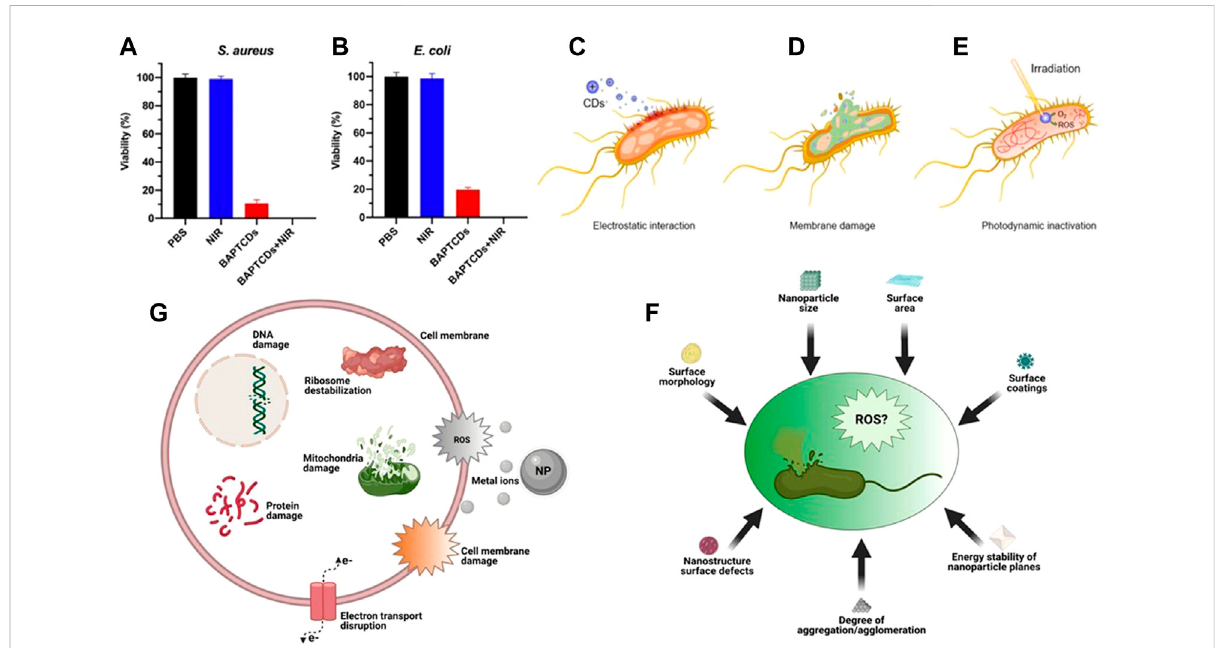
FIGURE 6 Bacterial viability of E. coli (A) and S. aureus (B) were obtained by the colony-forming count method. Reproduced from (Qie et al., 2022) with permission from Frontiers in Bioengineering and Biotechnology. General bactericidal mechanisms of action of CDs. (C) Electrostatic interactions between CDs and bacterial cell walls. (D) Internalization of CDs leads to irreversible damage caused by cytoplasmic leakage (E) CDs generate ROS under laser irradiation causing DNA damage. (F) Some factors of ROS productioninducedby carbon points and inhibition of bacteria. (G) Some mechanisms of toxicity of NPs. Reproduced from (Yougbare et al., 2021b) with permission from International Journal of